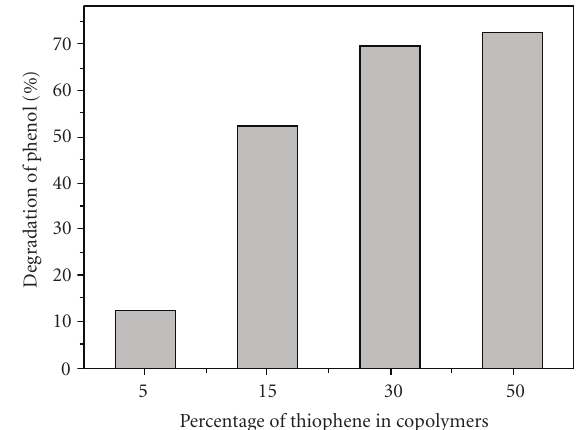
Figure 3: Photodegradation of phenol using PFT-sensitized TiO 2 [phenol] i = 10 mg/L, [photocatalyst] = 1g/L, irradiation time = 10